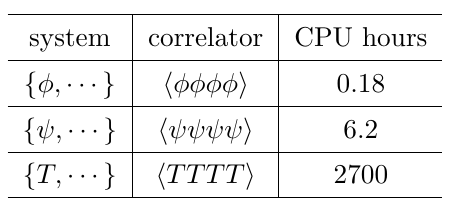
Table 6 : Estimates of CPU hours needed for the computation of select static blocks in various systems of